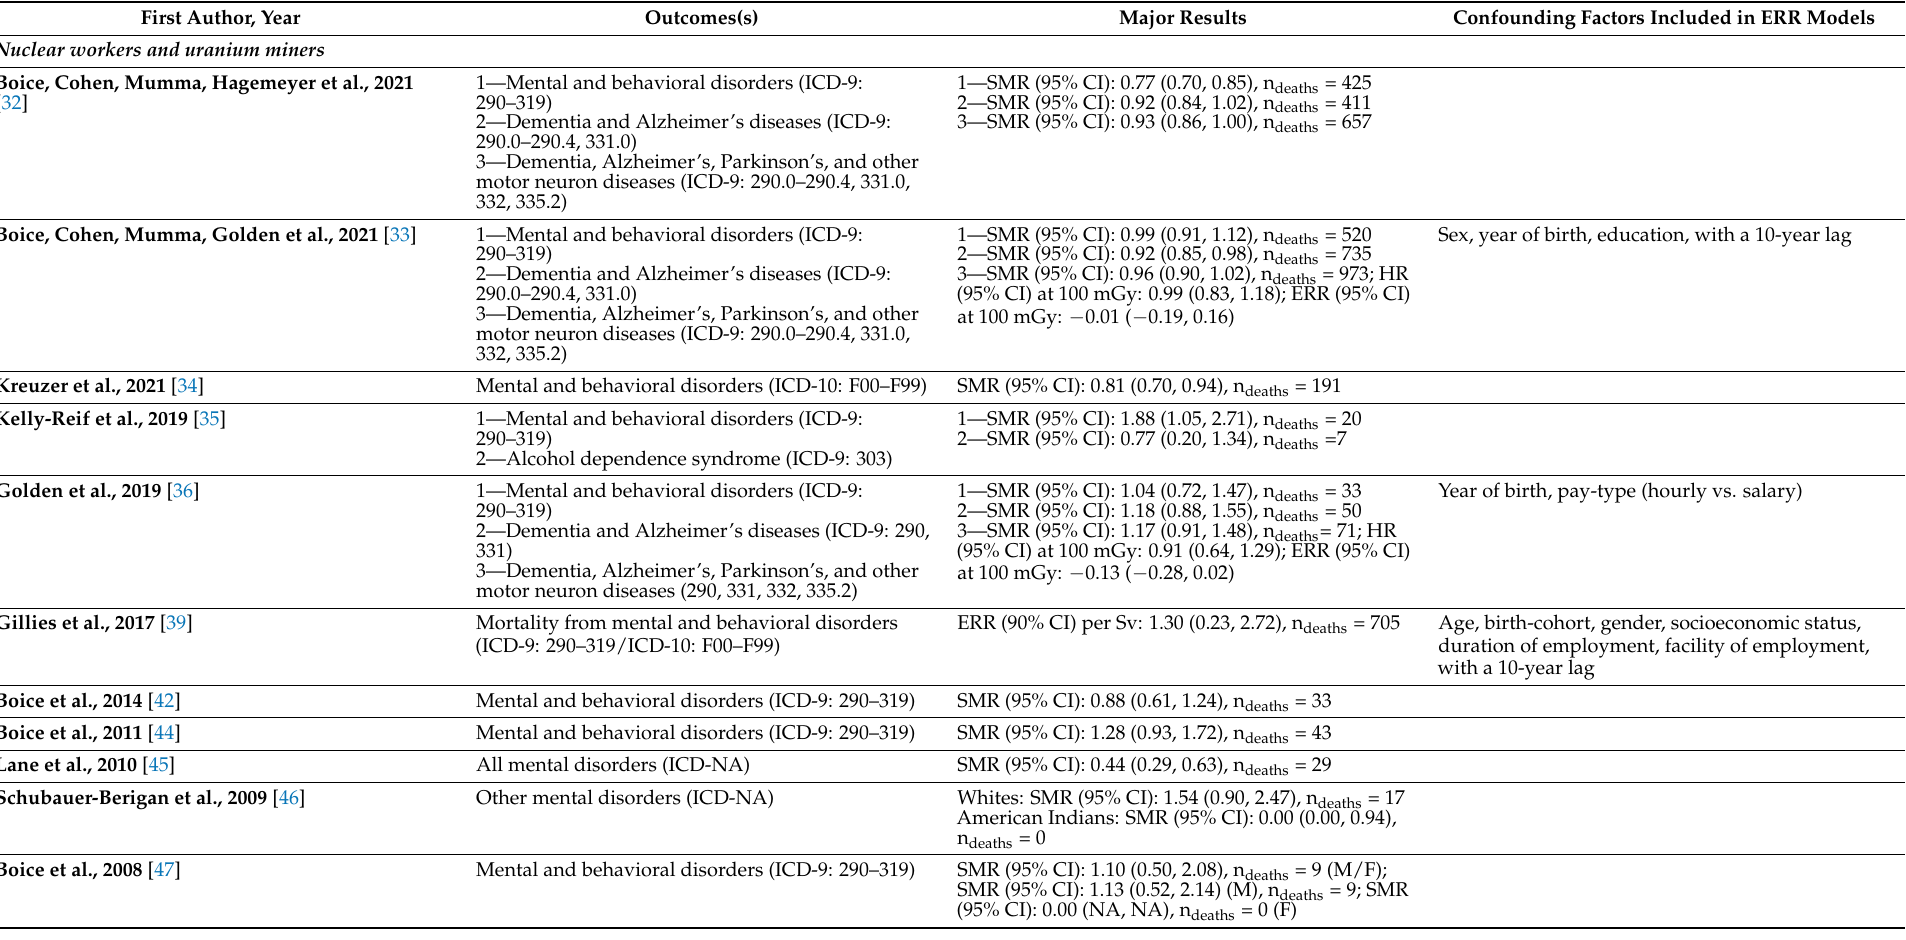
Table 4. Key findings of the included studies on mental and behavioral